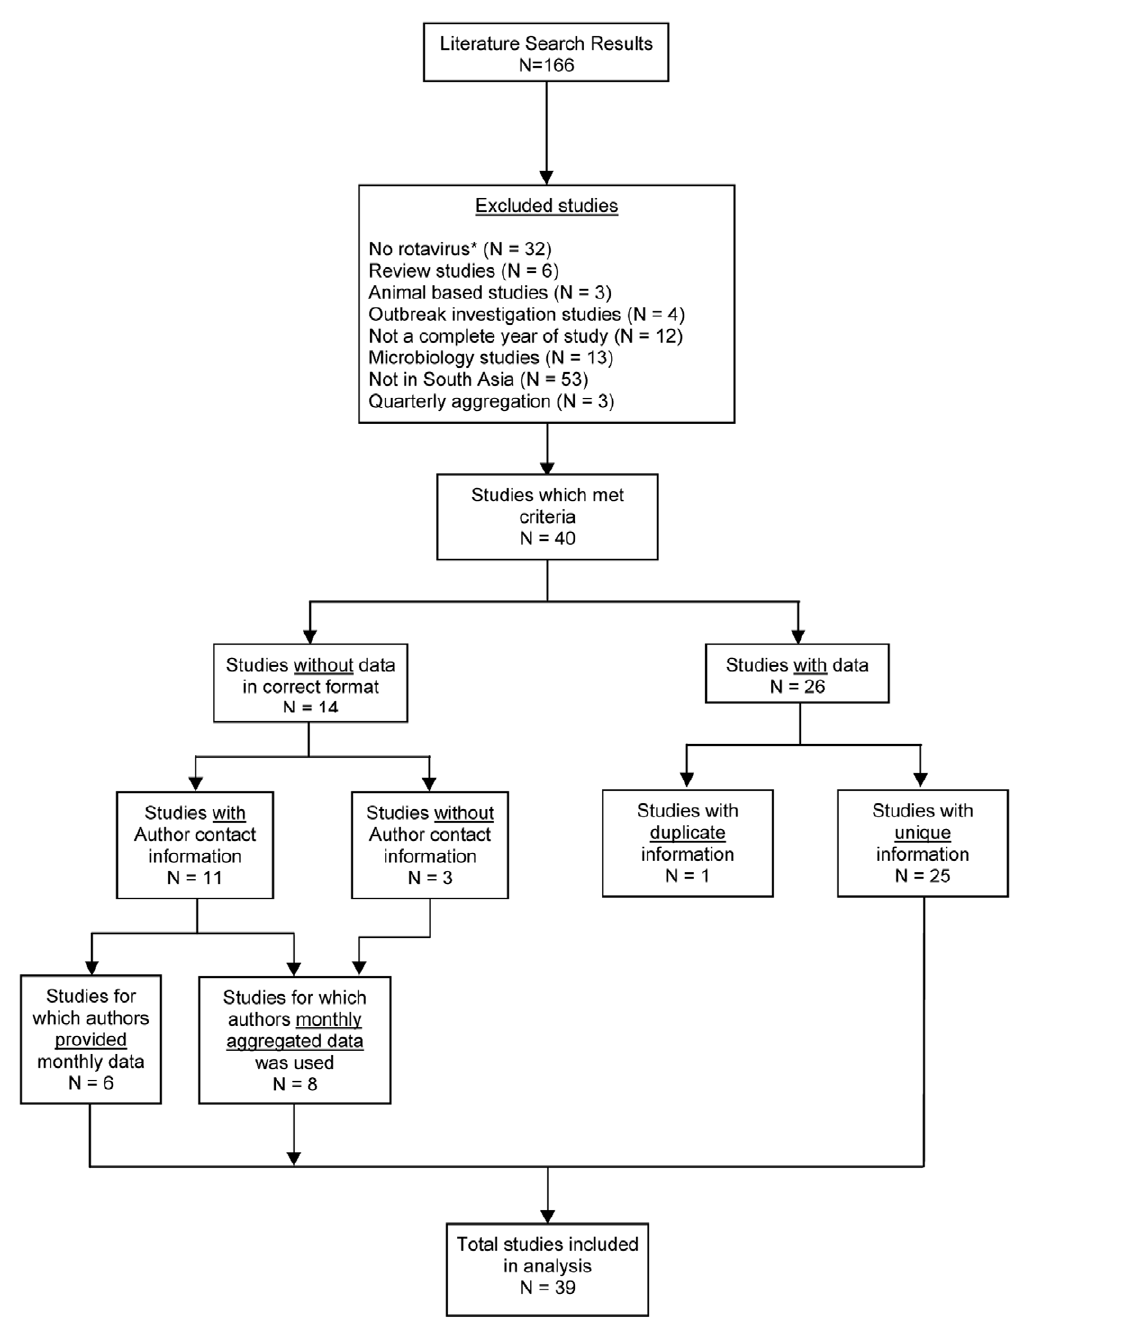
Figure 1. Study selection flow chart. Flow chart of selection of studies utilized in the meta-analysis including inclusion and exclusion criteria.